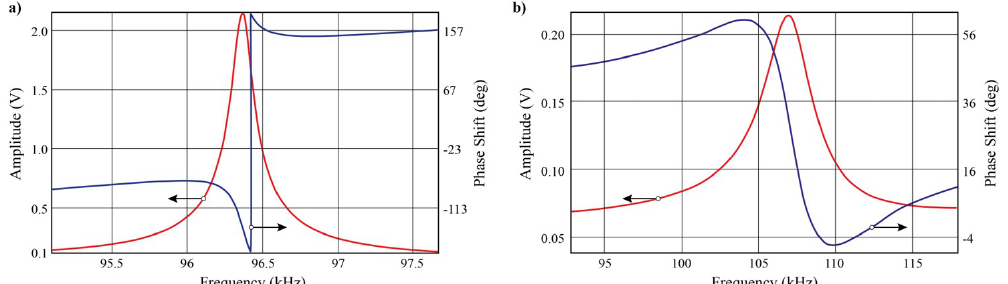
Figure 3. Frequency sweep results with amplitude (red), phase (blue) for one cantilever probe ( a ) before coating with resonance frequency at 96.365 kHz, ( b ) after coating with resonance frequency at 106.564 kHz (oscillation amplitudes in unit of volts are recorded instead of gains from the data acquisition system with the same driving signals applied during the sweep for